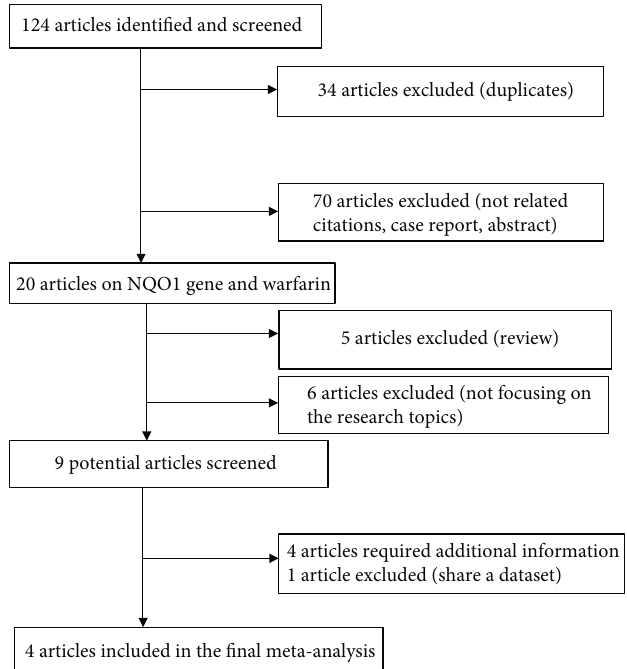
Figure 1: Flow diagram of the literature screening process used for the meta-analysis of NQO1 polymorphisms and warfarin maintenance